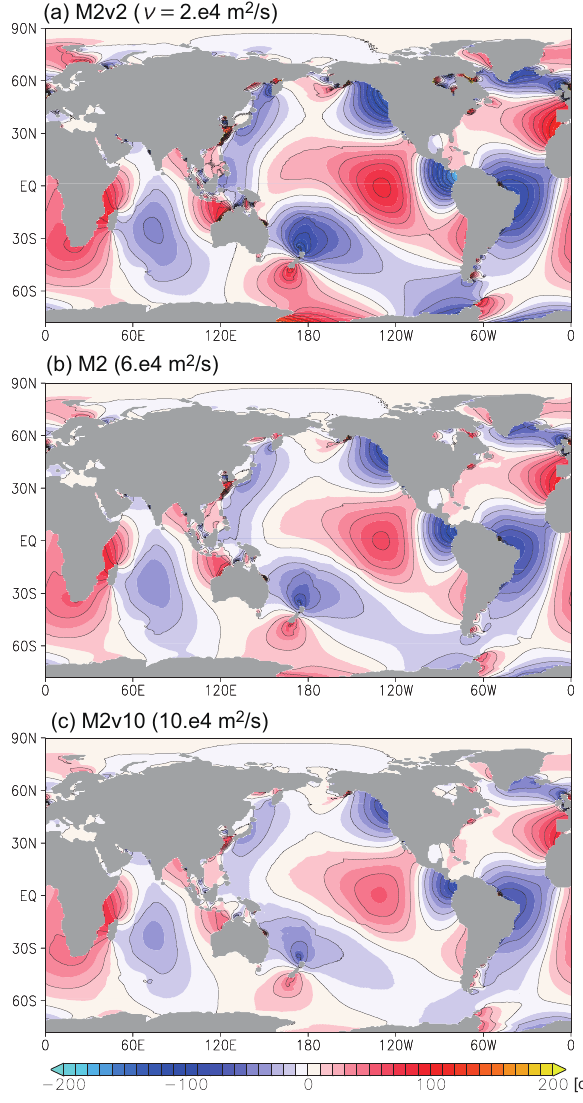
Fig. 9. Tidal height η t at the end of the 10-day experiments (00:00 on 21 May 2001) in cases (a) M2v2 ( ν = 2 × 10 4 m 2 s − 1 ), (b) M2 (6 × 10 4 ) and (c) M2v10 (10 × 10 4 ). The contour interval is 20cm. ing active excitement due to interaction between tides and topographies. This is consistent with the energy dissipation D in Fig.